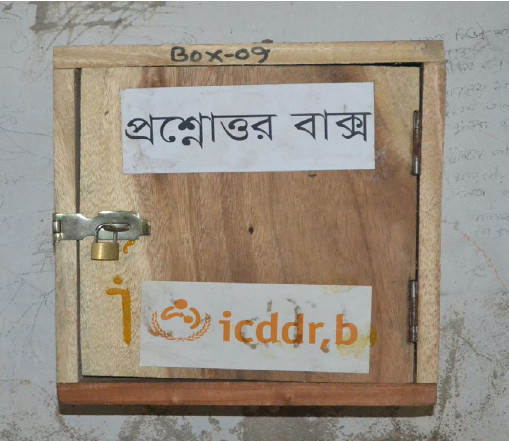
Figure 1. Wooden ‘Question Box’ used by adolescent school students for anonymous question submission during a 6-month pilot study in four schools in Bangladesh between August 2017 to April 2018. The wooden box cost BDT 360 (USD 4.12). It had a slit in the top and was kept under lock-and-key in all classrooms where teachers conducted puberty education sessions, as part of a menstrual hygiene management intervention at the four schools in rural and urban Bangladesh. Students were encouraged to anonymously submit general puberty and menstruation-related questions into the wooden box if they felt uncomfortable asking aloud during class.